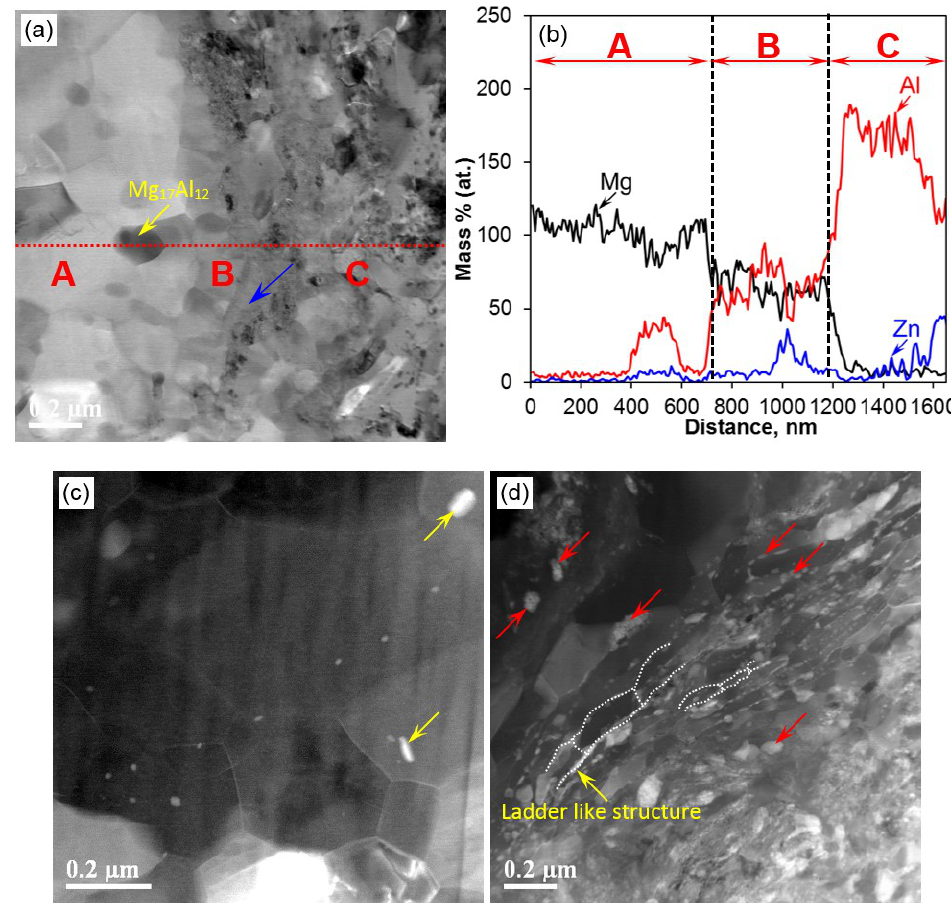
Figure 4. Transmission electron microscopy (TEM) micrographs show the different zones of the cold spray (CS)-coated specimen: substrate (A), interface (B) and coating (C) of AZ31B alloy coated with AA7075 alloy in different modes: ( a ) bright field image, with ( b ) EDX line scan, STEM-High-angle annular dark-field (HAADF) image of ( c ) substrate and ( d ) coating Note: Yellow arrows—Mg 17 Al 12 , Red arrows—MgZn 2 , white line—ladder like grains. The raw data required to reproduce these findings are available to download from http://dx.doi.org/10.17632/5b5rk27wmx.1.